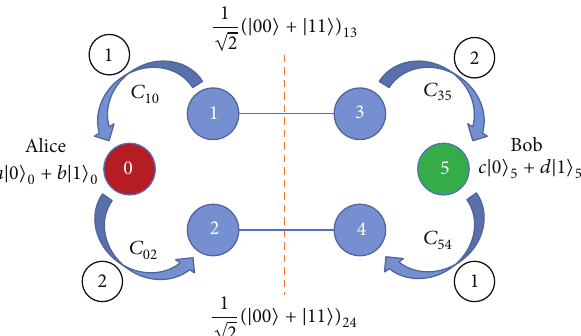
Figure 3: The demonstration of nonlocal swap gate